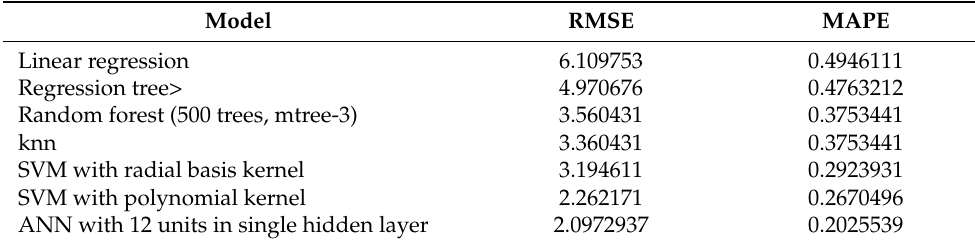
Table 2. Results of predictors.